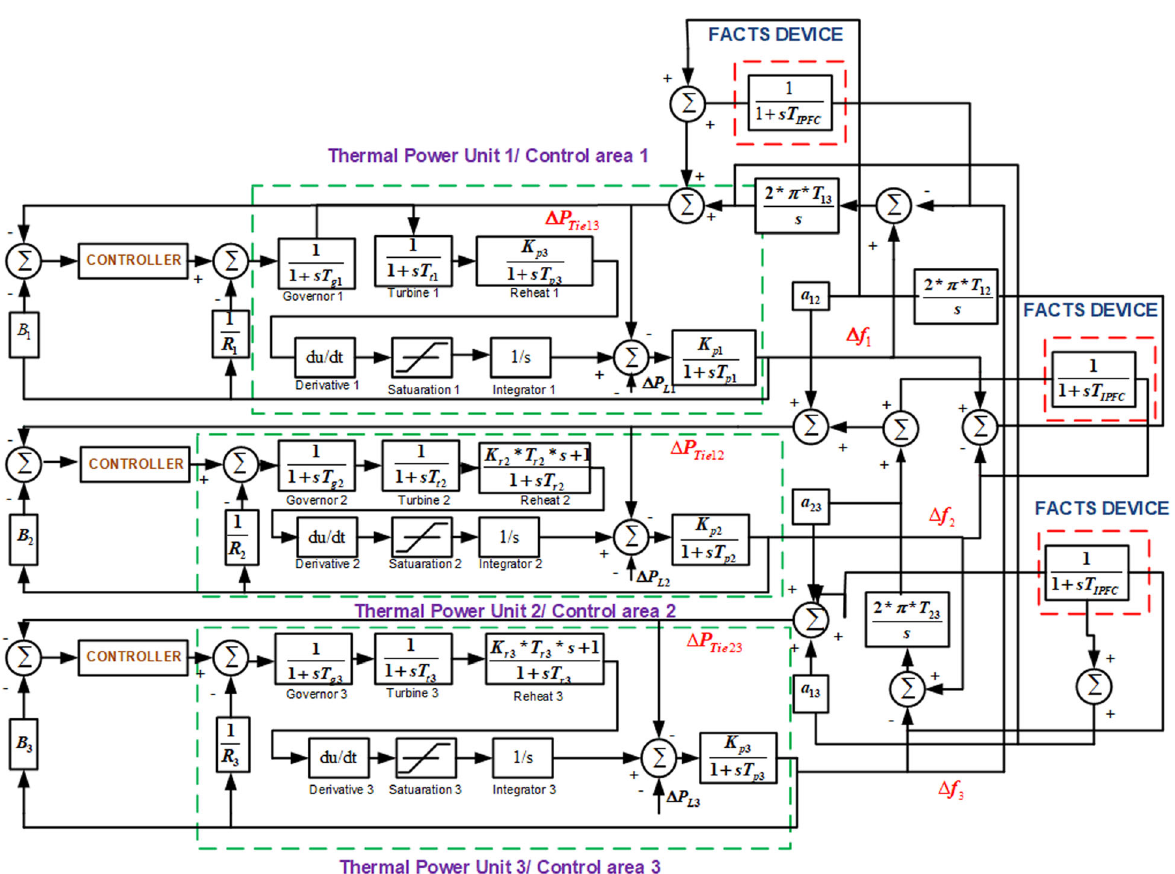
Fig. 1 Simulation prototype of a reheat turbine fitted thermal network with 1% SLP and 3%